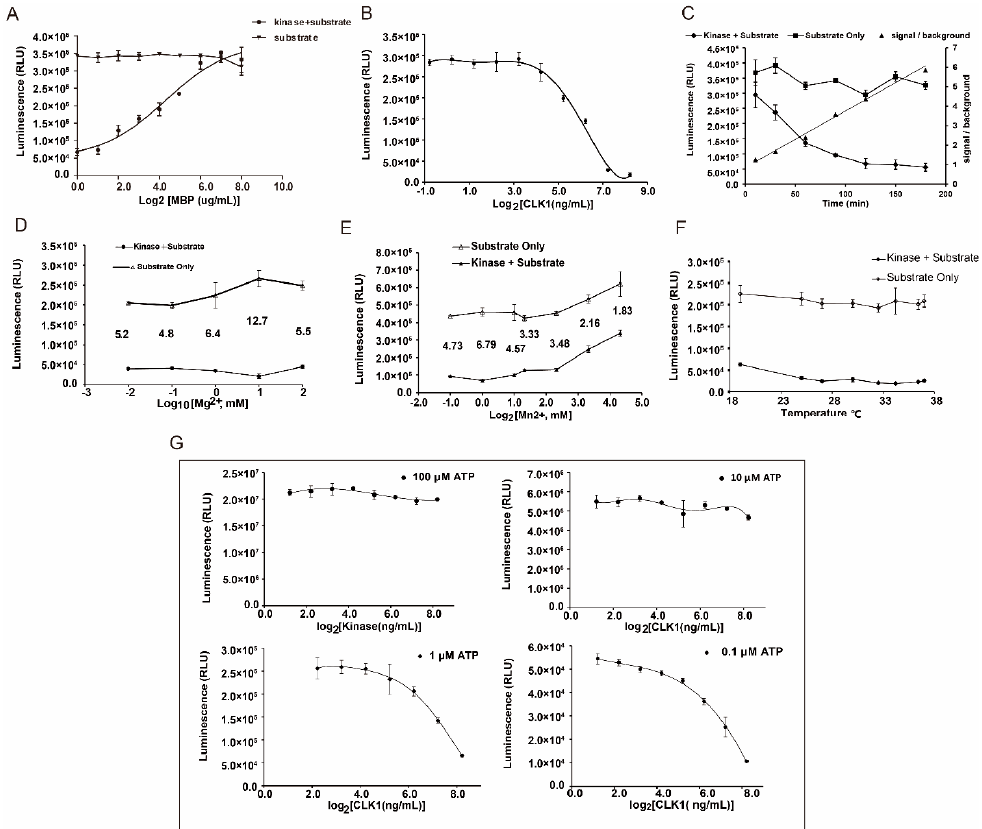
Figure 3. Optimization of parameters in Kinase-Glo ® luminescent kinase assay. ( A ) Substrate concentration-dependent phosphorylation of CLK1; ( B ) Enzyme concentration-dependent phosphorylation of CLK1. ATP concentrations and MBP concentrations were 1 µ M and 50 ng/ µ L, and incubation times were 90 min at 25 ˝ C; ( C ) Time-dependent phosphorylation of CLK1. The incubation times of kinase reaction were set as 10, 30, 60, 90, 120, 150 and 180 min; ( D ) Mg 2+ concentration-dependent phosphorylation of CLK1; ( E ) Mn 2+ concentration-dependent kinase reaction of CLK1; ( F ) Temperature-dependent phosphorylation of CLK1; ( G ) ATP concentration-dependent phosphorylation of CLK1 with concentrations of 0.1, 1, 10 and 100 µ M.